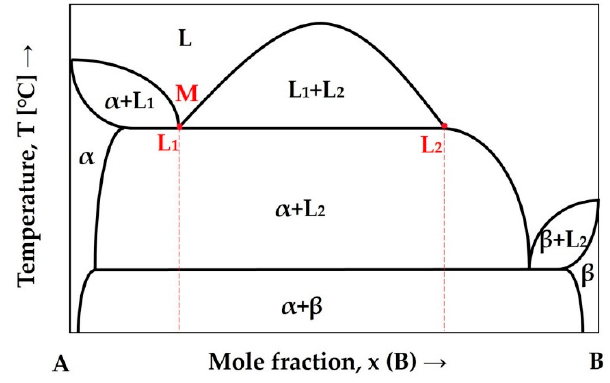
Figure 8. Phase diagram of a monotectic reaction.